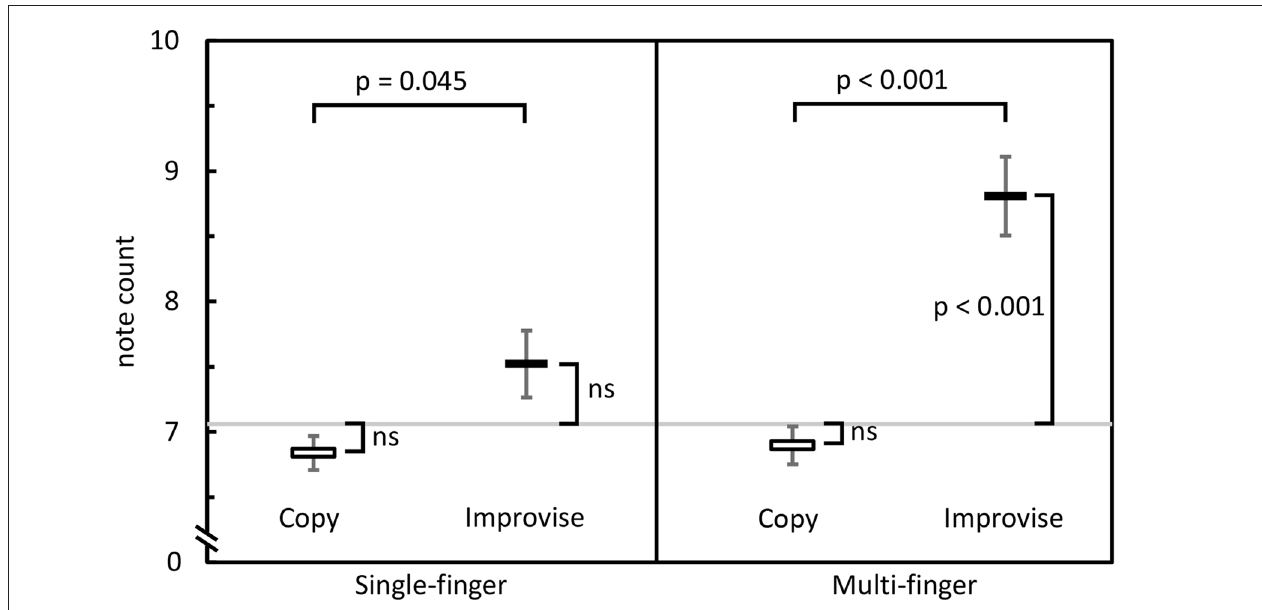
FIGURE 2 | Behavioral comparisons. Mean note counts for Copy and Improvise in the Single-finger and Multi-finger tasks ( N = 13). Results indicated increased rhythmical freedom in subject responses during Improvise conditions, and a high degree of accuracy during Copy conditions. The horizontal gray line represents the mean note count across all 16 stimulus patterns